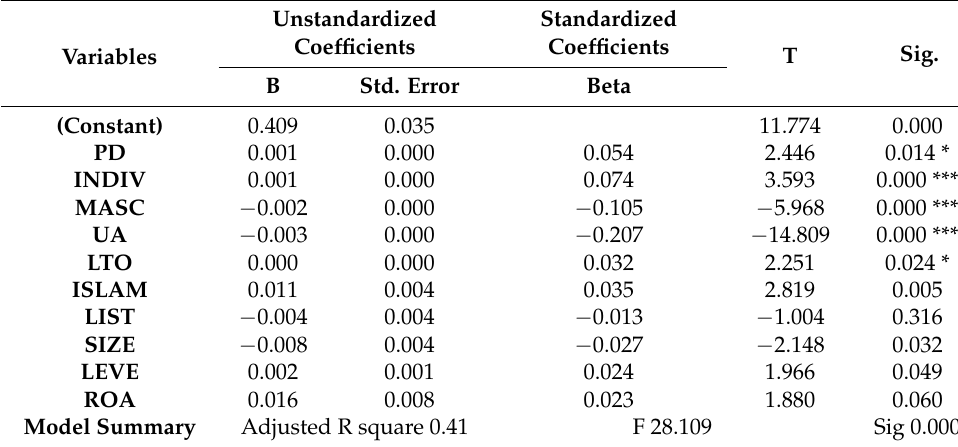
Table 5. Model 2: Results with control bank type (Islamic or Non-Islamic).